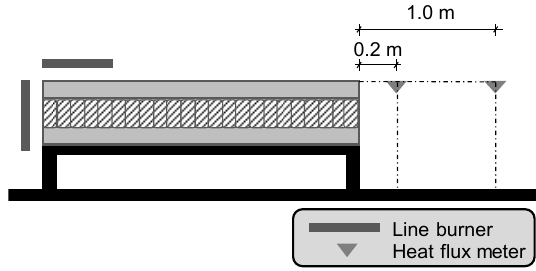
Figure 3. Installation position of heat flux meter (HB = 115 mm).